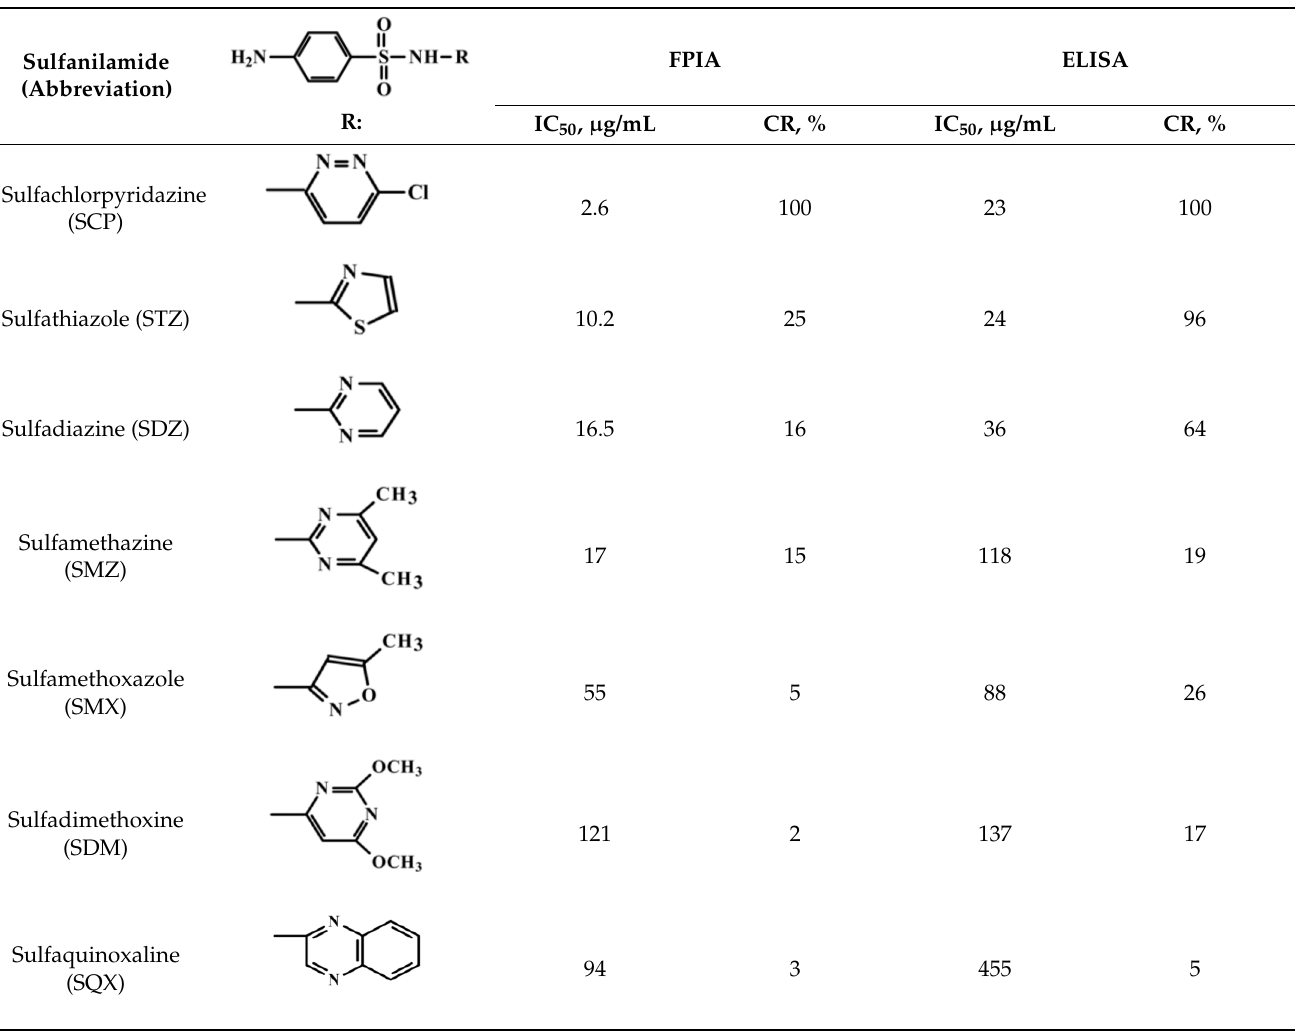
Table 2. Sulfonamides used in the work and their IC 50 and CR values relative to sulfachlorpyridazine for FPIA and ELISA techniques.